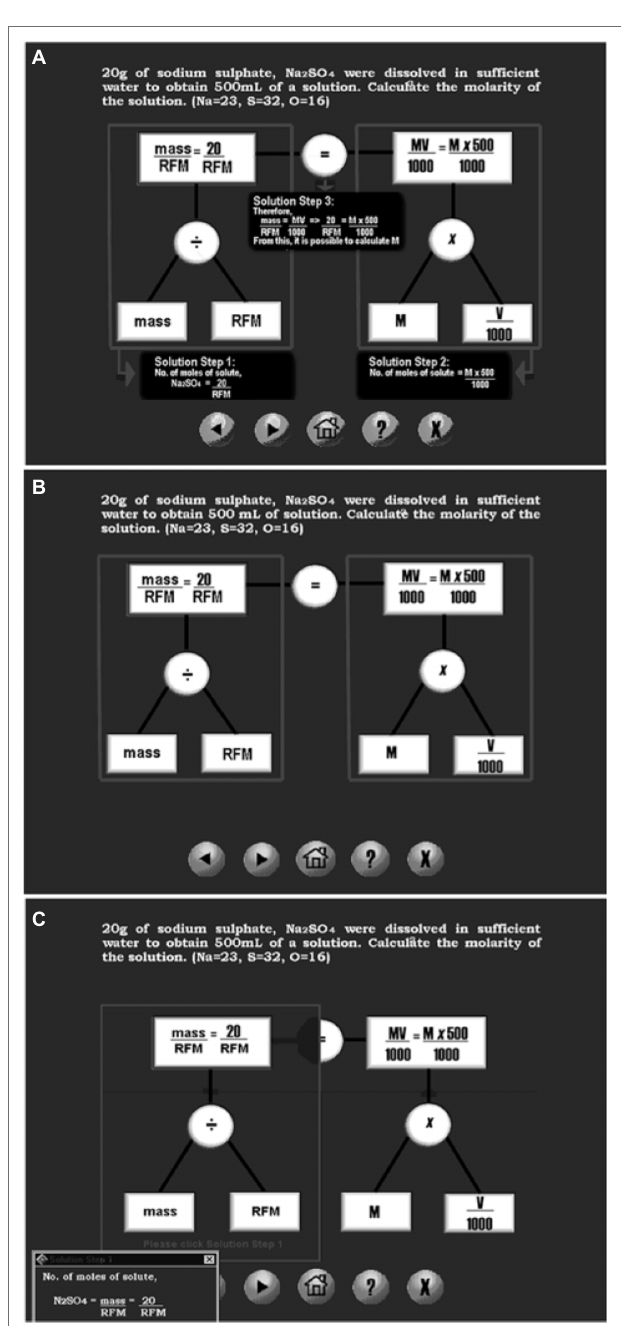
FIGURE 1 | A worked example of a molarity problem: (A) static-solution format, (B) no-solution format, and (C) interactive-solution format. Source: Ngu et al.